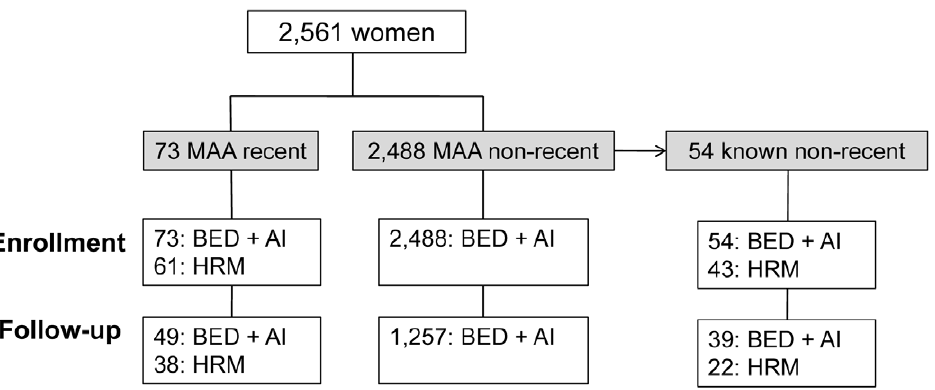
Figure 1. Samples used for analysis (see text). Samples collected at study enrollment were available for 2,561 (76.8%) of the 3,335 women enrolled in the PEPI-Malawi trial. The figure shows the number of samples available for analysis using the BED assay (BED), the avidity assay (avidity index, AI) and the HRM diversity assay (HRM) at enrollment and follow-up (12–24 months after enrollment). Different subsets of women were evaluated, including women identified as recently infected at enrollment using the multi-assay algorithm (MAA recent), women identified as not recently infected at enrollment using the MAA (MAA non-recent), and women who were known to have non-recent HIV infection at enrollment (known